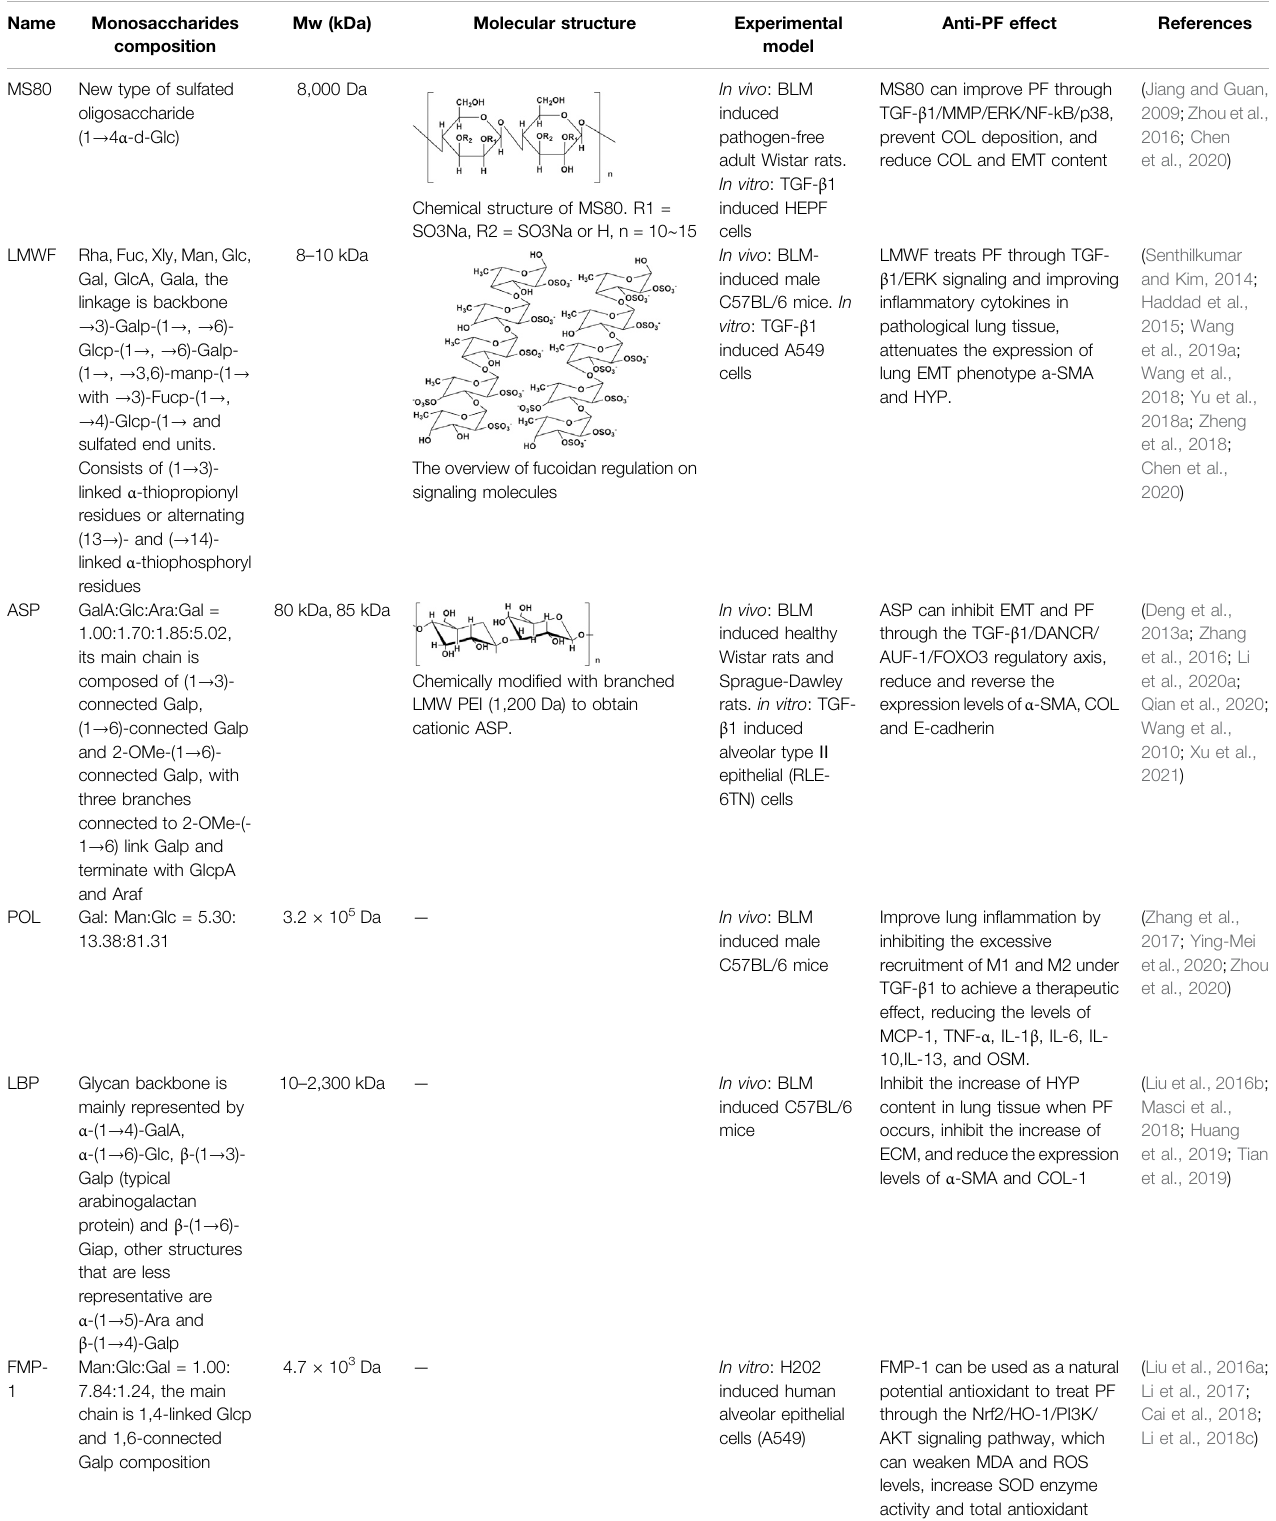
TABLE 1 | ( Continued ) Overview of the research progress of Chinese herbal medicine polysaccharides in the treatment of